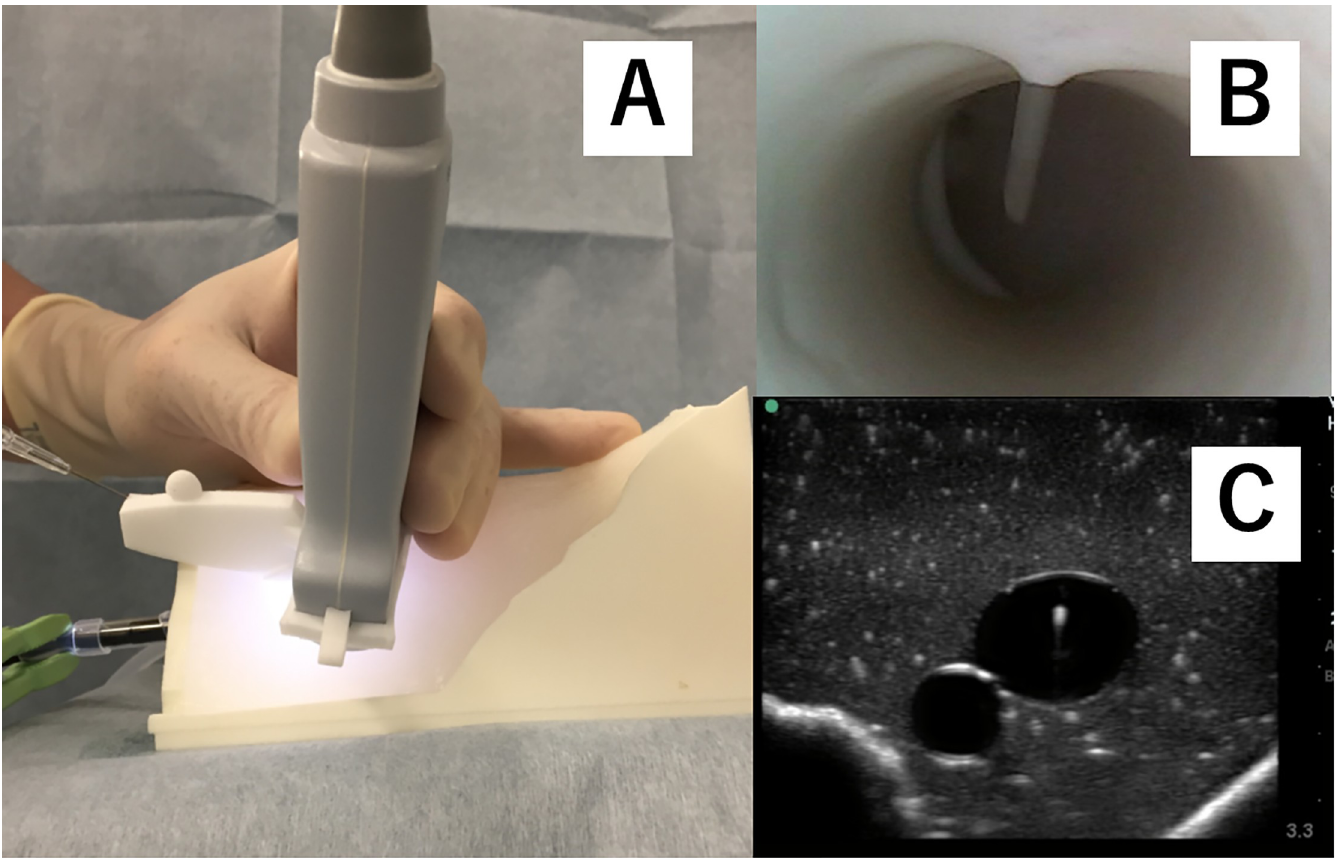
Fig 5. A novel shallow angle of approach needle guide. Panel A: The needle insertion site is far from the probe, 2.5cm cephalad and the needle is inclined at 30 degrees to the simulated vein, which allows a shallow angle of approach to the simulated internal jugular vein. Panel B: Internal view of the simulated vein. Panel C: The needle tip appears in the ultrasound image at a depth of 1.5 cm.